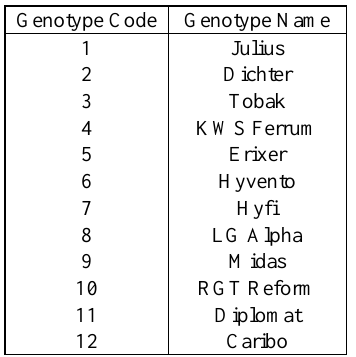
Table 1. Genotypes within Experiment field